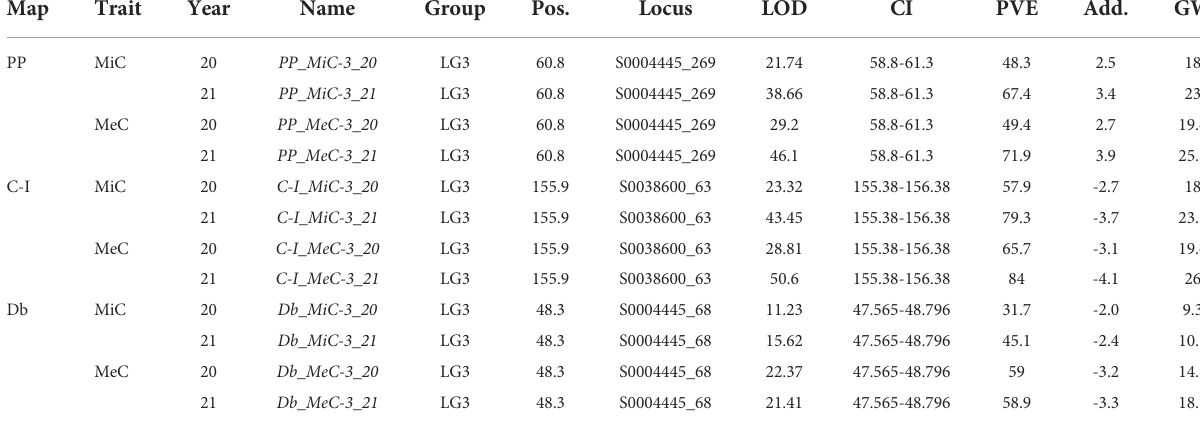
TABLE 4 QTL detected in the mapping population.